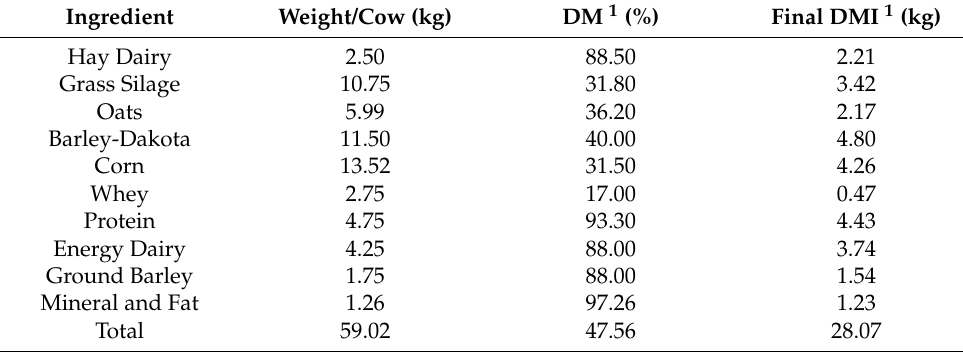
Table 2. Feed ingredients of cows during early